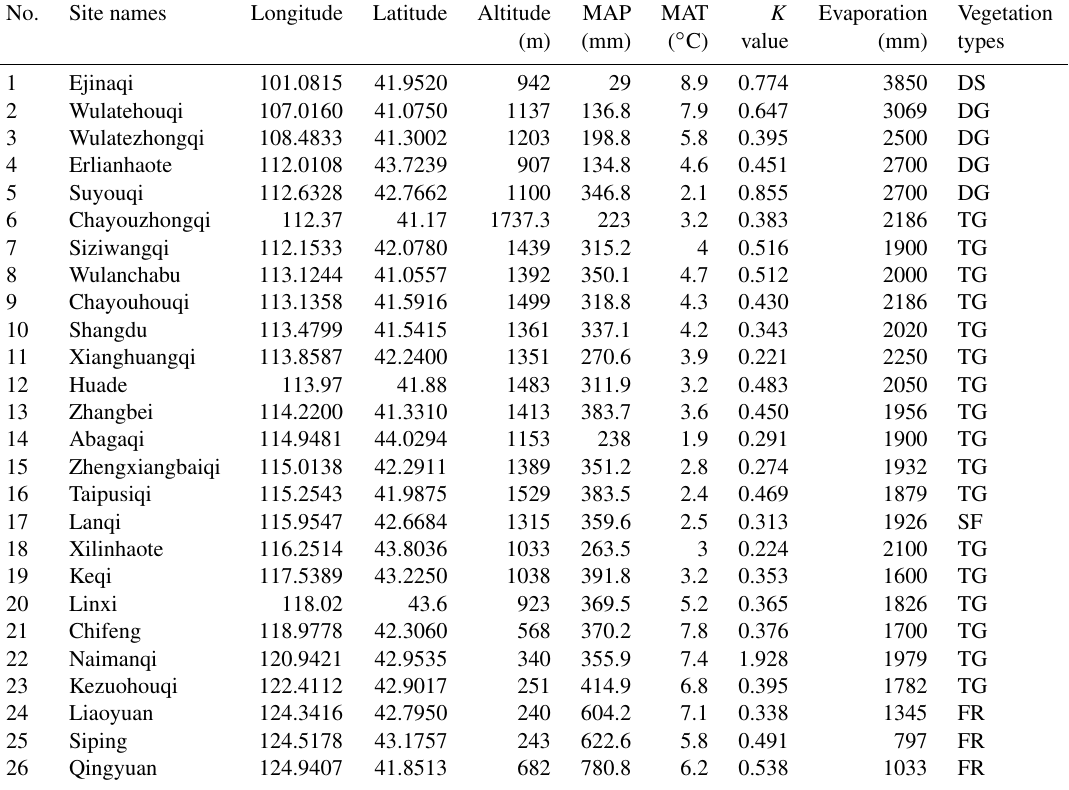
Table 1. Information about geographic positions and environmental factors in 26 sampling sites in the Inner Mongolian plateau and north- eastern China (MAP: mean annual precipitation, MAT: mean annual temperature, K value: phylogenetic signal values, the small the values, the weak the signals. Vegetation types: deserts (DS), desert grasslands (DG), typical grasslands (TG), sparse forest (SF), forests (FR).